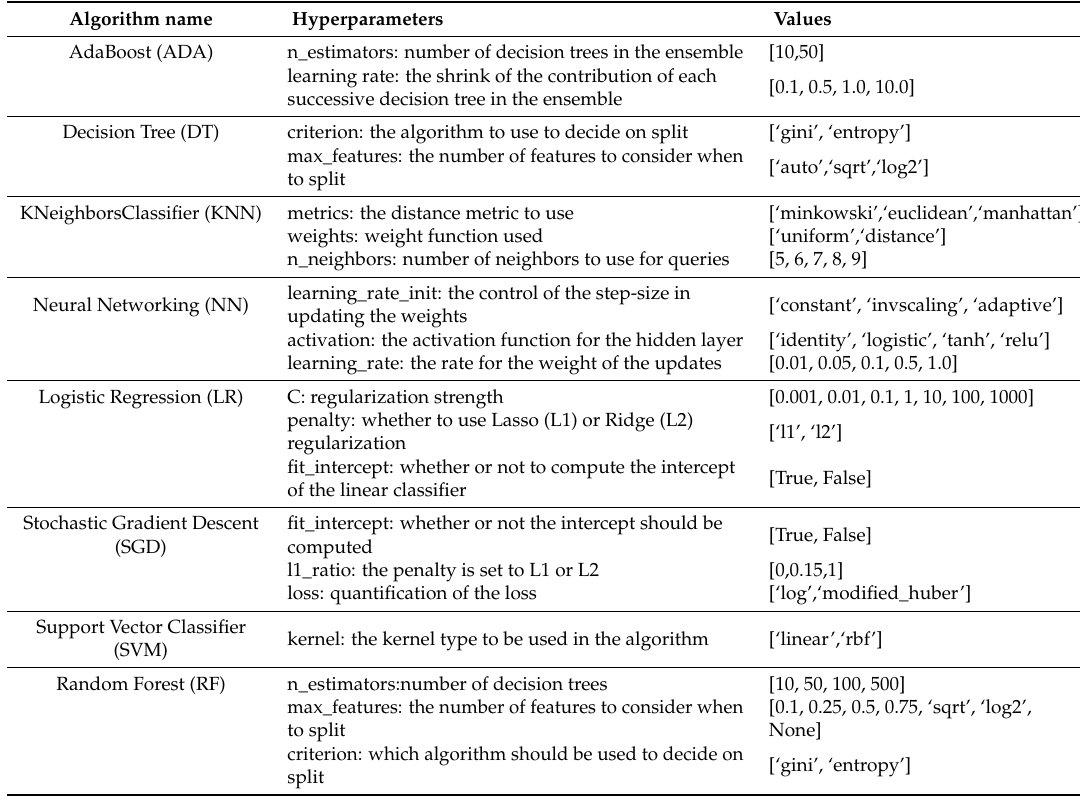
Table 3. Algorithms, used parameters, and grid search values.